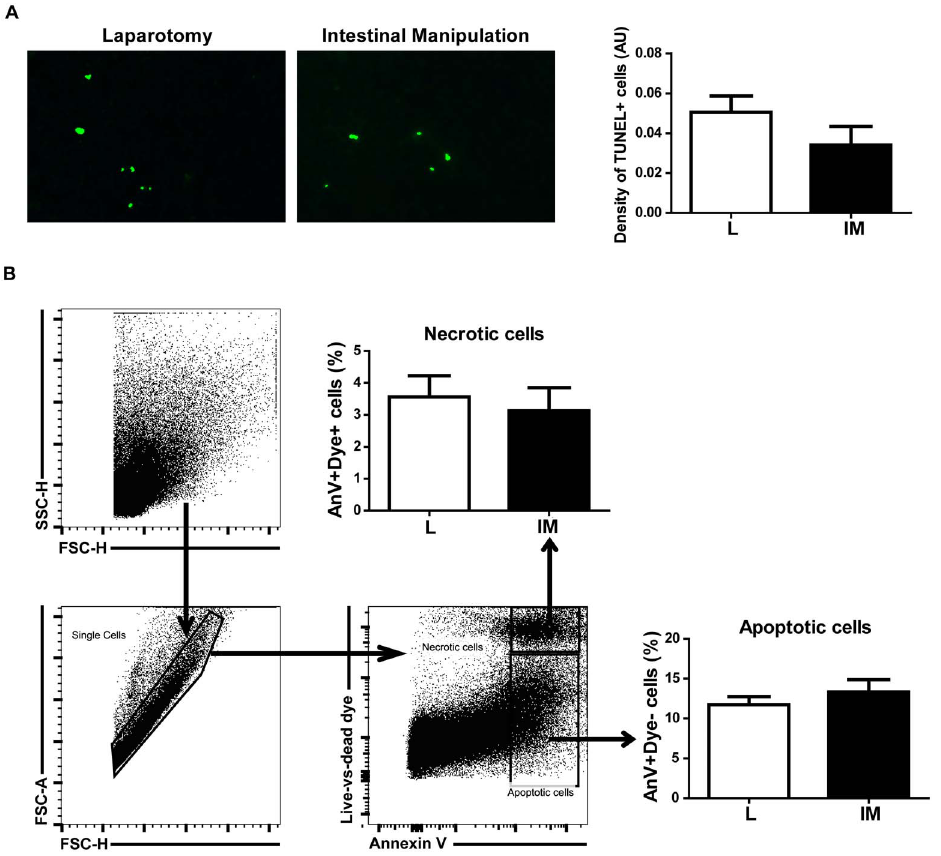
Figure 3. Intestinal manipulation doesn’t increase splenocyte cell death. A. Late apoptosis was determined in the spleen by a TUNEL immunofluorescent assay 24 h after IM. No difference was observed in the density of apoptotic cells (in green) between L and IM groups. B. Necrotic (AnnexinV + Live/dead marker + ) and apoptotic cell death (AnnexinV + Live/dead marker-) in the spleen were quantified by FACS analysis 24 h after IM. The percentage of necrotic and apoptotic cell death remains unchanged between L and IM mice. Data shown are mean 6 SEM of 2 independent experiments (n=4 animals per group) (Student t-test).